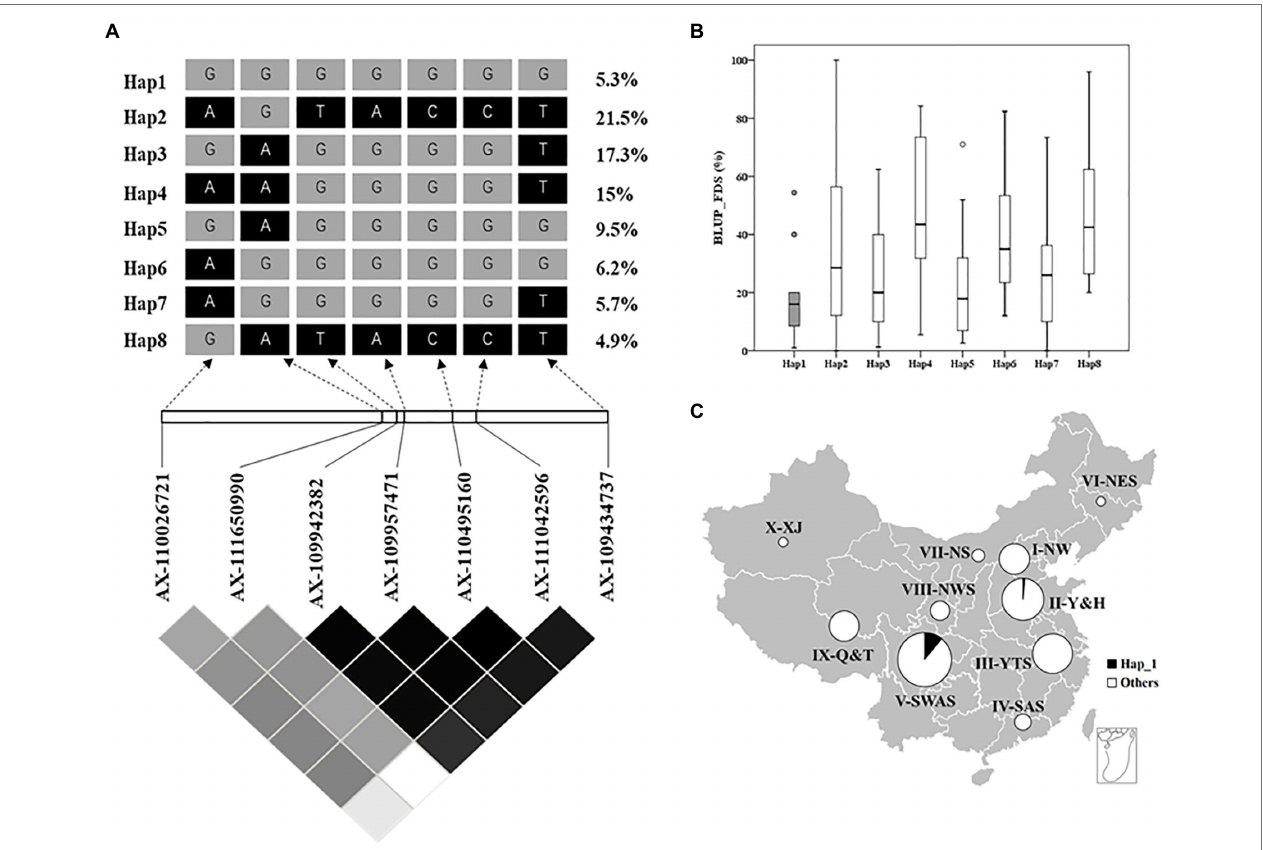
FIGURE 4 | Haplotype analysis of QYr.GX-2AS associated with stripe rust resistance in 325 Chinese wheat landraces. (A) LD heat map surrounding QYr.GX-2AS . The number on the right shows the distribution frequency of eight haplotypes in these Chinese wheat landraces. (B) Boxplot displays the mean final disease severity of the accessions carrying different haplotypes. (C) Frequencies of resistance allele of QYr.GX-2AS in Chinese wheat landraces in 10 major agro-ecological production zones of